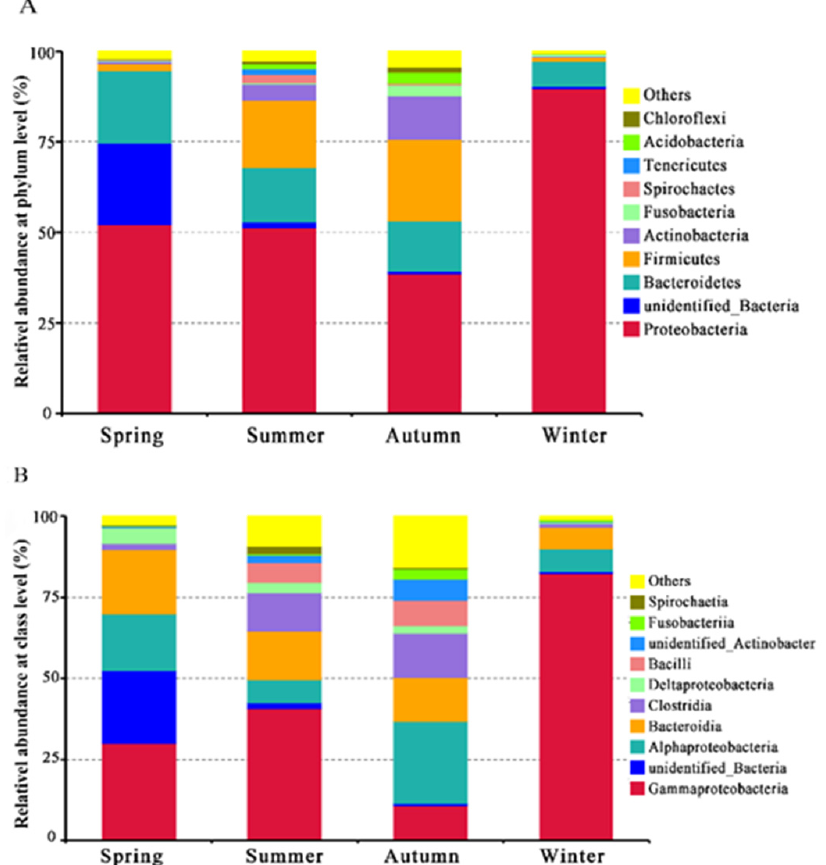
Figure 4. Comparison of microbial community structures on the different seasonal groups. ( A ) mi- crobial community compositions at the phylum level. ( B ) microbial community compositions at class level.